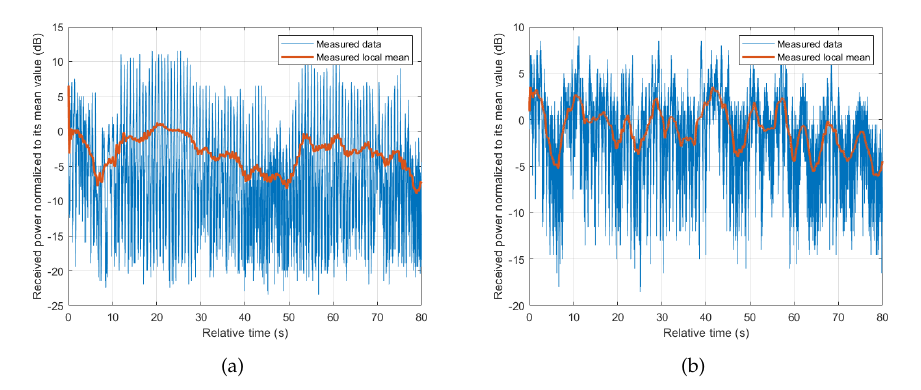
Figure 4. Example of measured time series collected in Scenario 2, (subject beside the other). ( a ) running; ( b )